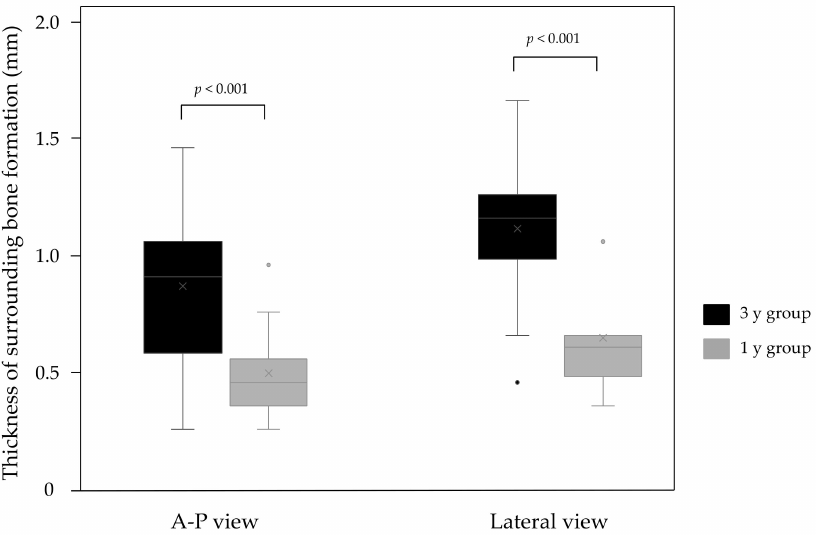
Figure 5. In both AP and lateral views, the 3 y group had a significantly thicker bone formation than the 1 y group ( p < 0.001). AP,